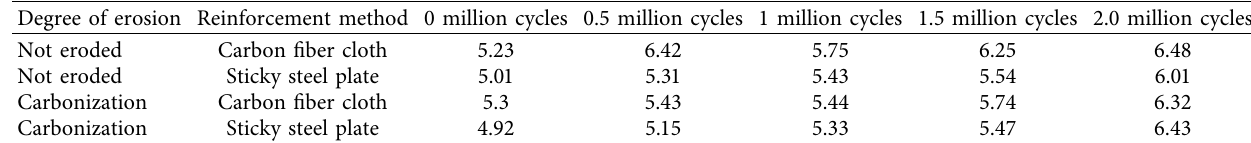
Table 18: The relation between damping and fatigue loading times for reinforced plate corroded by